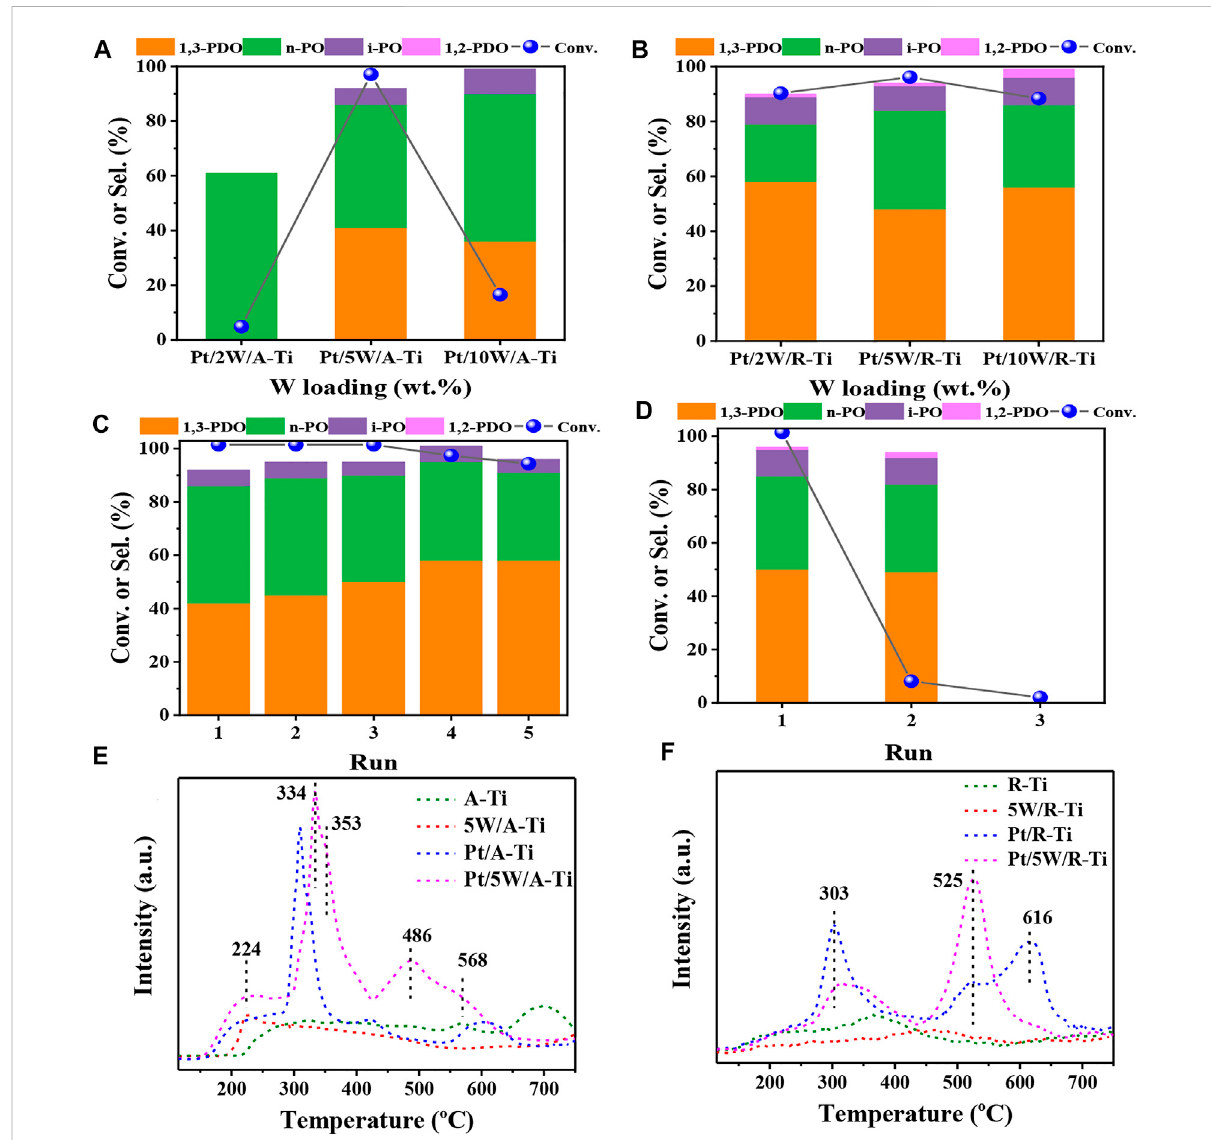
FIGURE 2 Comparative results obtained for the Pt/W/A-Ti (A) and Pt/W/R-Ti (B) fabricated under conditions of varying WO x loadings. The cycle stability tests of Pt/5W/A-Ti (C) and Pt/5W/R-Ti (D) . NH 3 -TPD pro fi les recorded for the catalysts and support A-Ti (E) and R-Ti (F) . Reaction conditions: 0.3 g of catalyst and 4.0 g of 10 wt% glycerol aqueous solution, 6 MPa H 2 , 140 ° C, 6